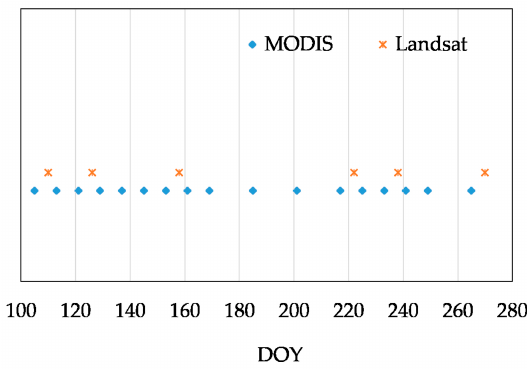
Figure 6. The dates for the available cloud free Landsat imagery and the MODIS time series data.